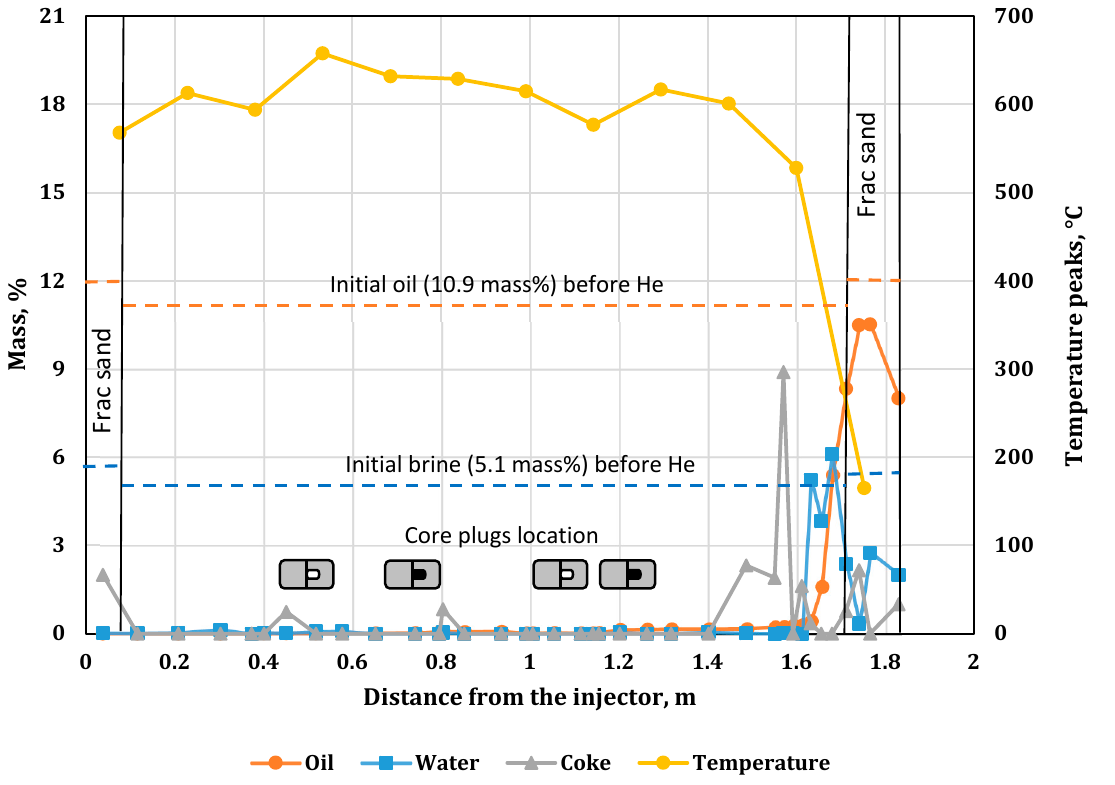
Figure 22. Residual oil, water and coke mass percent in the unpacked core.